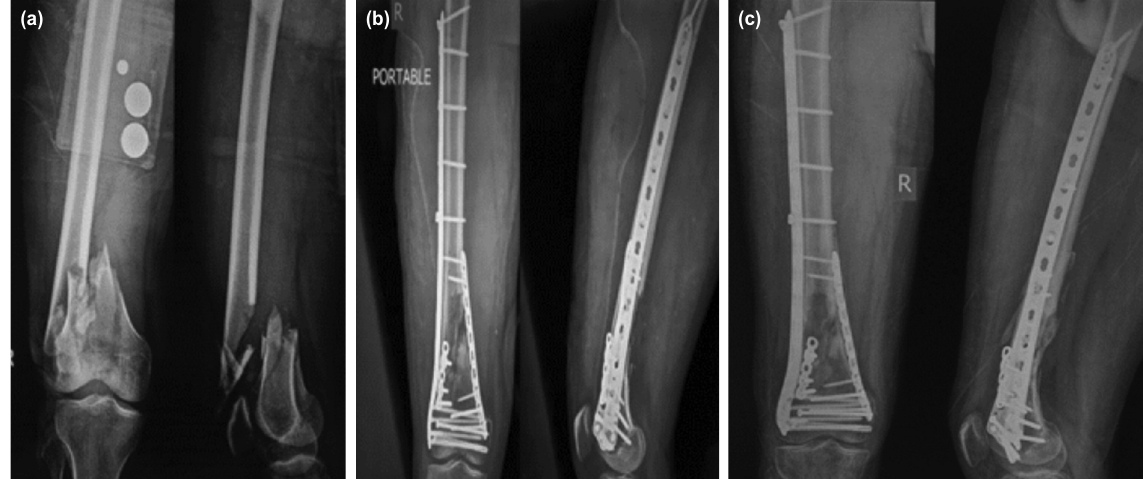
(a) Pre-operative radiograph (b) Immediate post-operative radiograph, (c) six months post-operative Fig. 3: